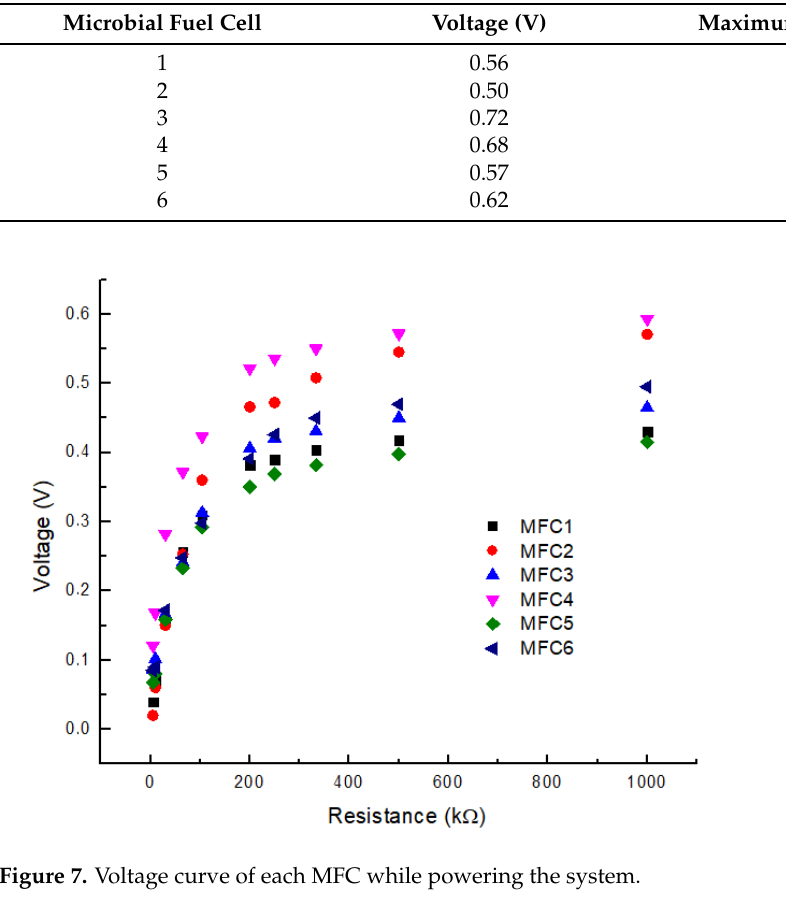
Table 2. Voltage and power of each MFC used in this paper.